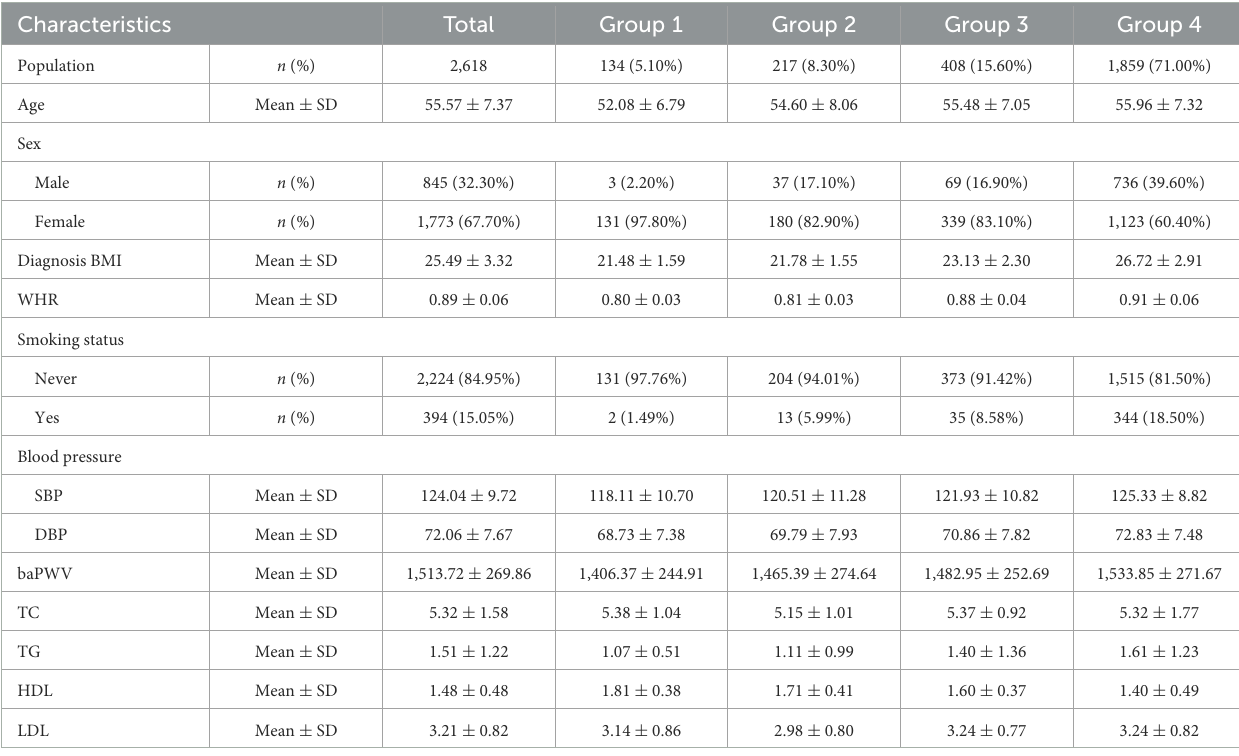
TABLE 1 Baseline characteristics of the total participants according to different BMI change groups.